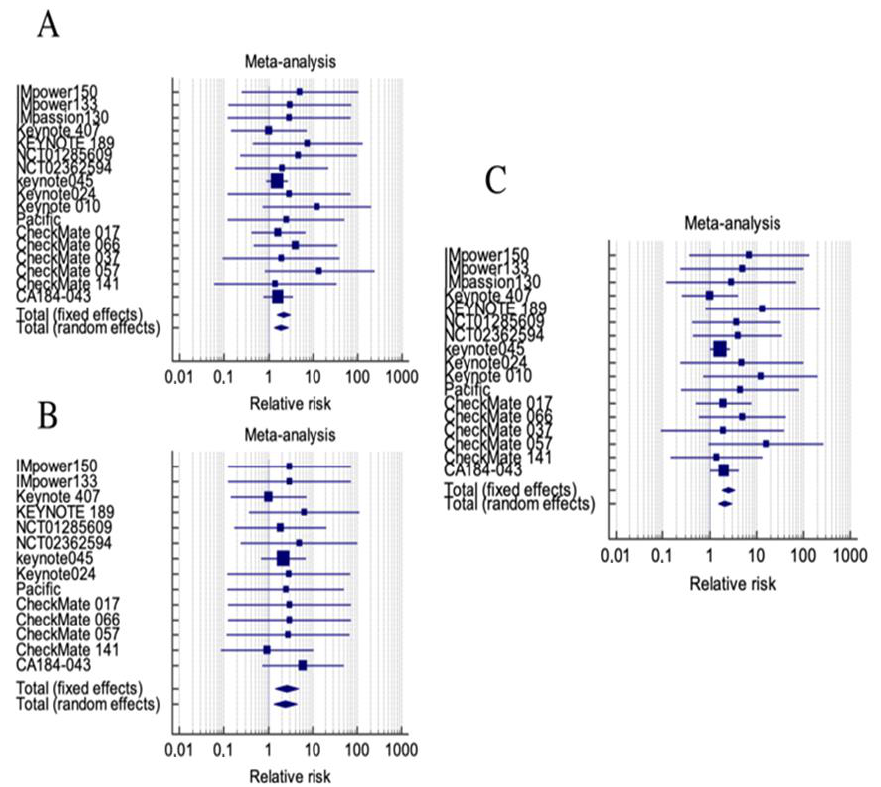
Figure 3. Forest plot of RD among patients receiving immune – checkpoint inhibitors. ( A ) Low grade toxicity, ( B ) high grade toxicity, ( C ) all grade toxicity.